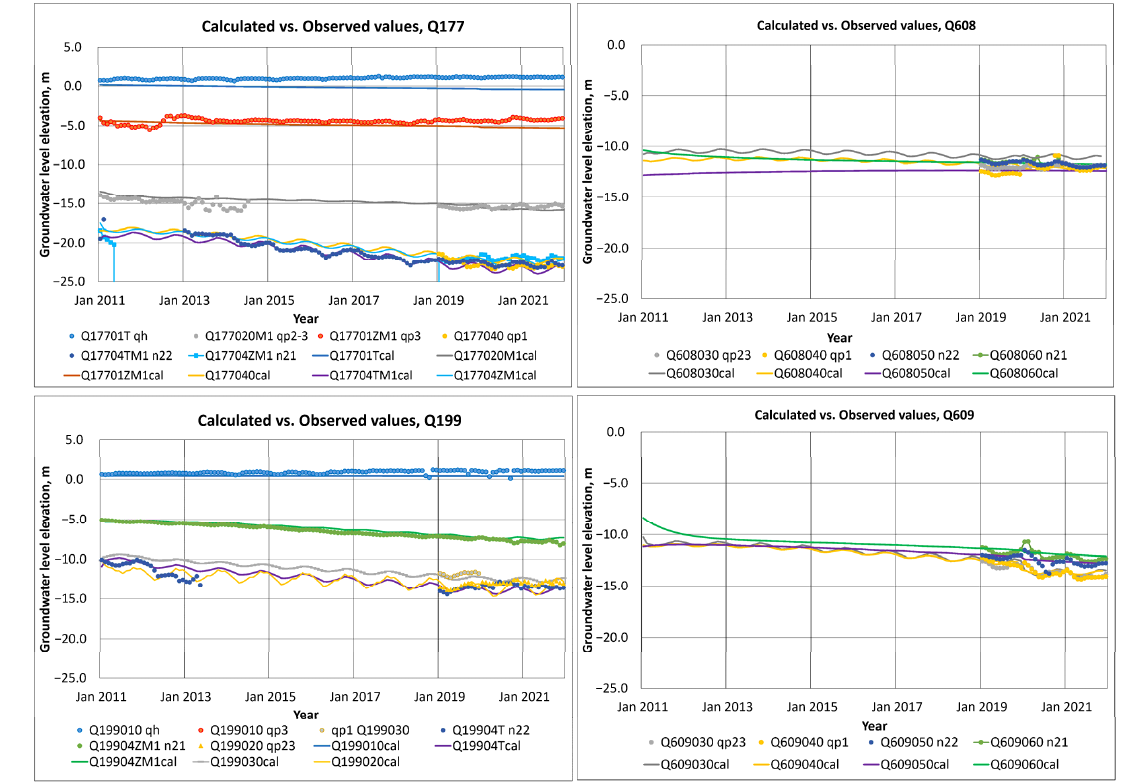
Figure 10. Time-dependent measured and calculated hydraulic heads for different well group and aquitard models.